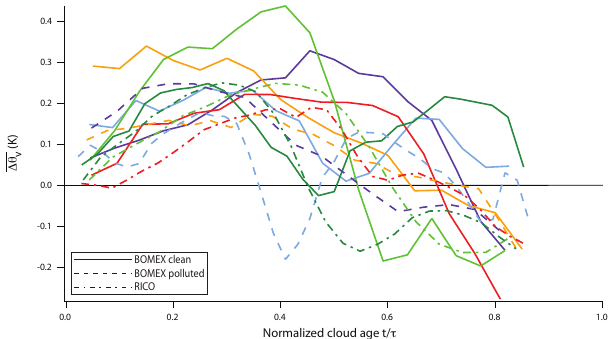
Figure 3. Volume-averaged time series of 1θ v .